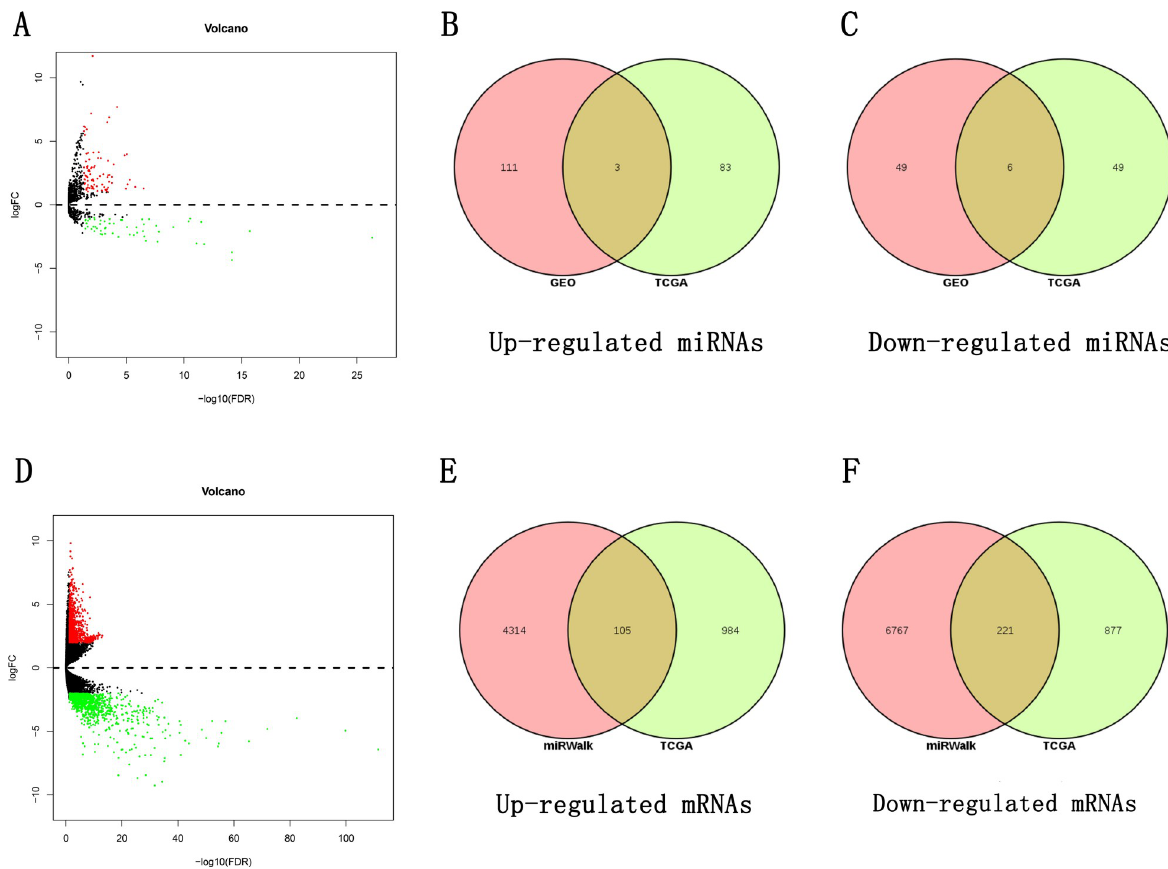
Fig 2. Differentially expressed miRNAs (DEMs) and differentially expressed genes (DEGs). (A) and (D) indicate the differential volcano plots of differentially expressed miRNAs in esophageal cancer tissues versus normal tissues in TCGA database and differential volcano plots of differentially expressed genes in esophageal cancer tissues versus normal tissues in TCGA database, respectively, where red indicates upregulation, and green indicates downregulation. (B) and (C) indicate the intersecting Venn diagrams of upregulated DEM1 and upregulated DEM2 and the intersecting Venn diagrams of downregulated DEM1 and downregulated DEM2, respectively. (E) and (F) indicate the Wayne diagrams of intersection of DEMs predicted upregulated target genes and TCGA database differentially expressed upregulated genes and the Wayne diagrams of intersection of DEMs predicted downregulated target genes and TCGA database differentially expressed downregulated genes, respectively.